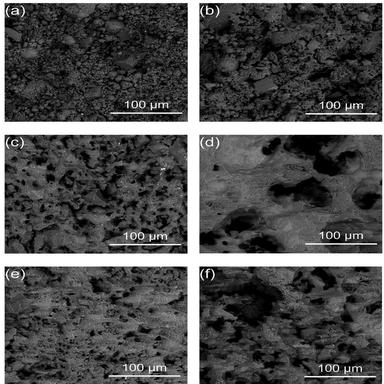
Back scattered SEM images of the samples. (a) S-3-1150, (b) S-3-1200, (c) S-3-1250, (d) S-3-1300, (e) S-1-1250 and (f) S-5-1250.